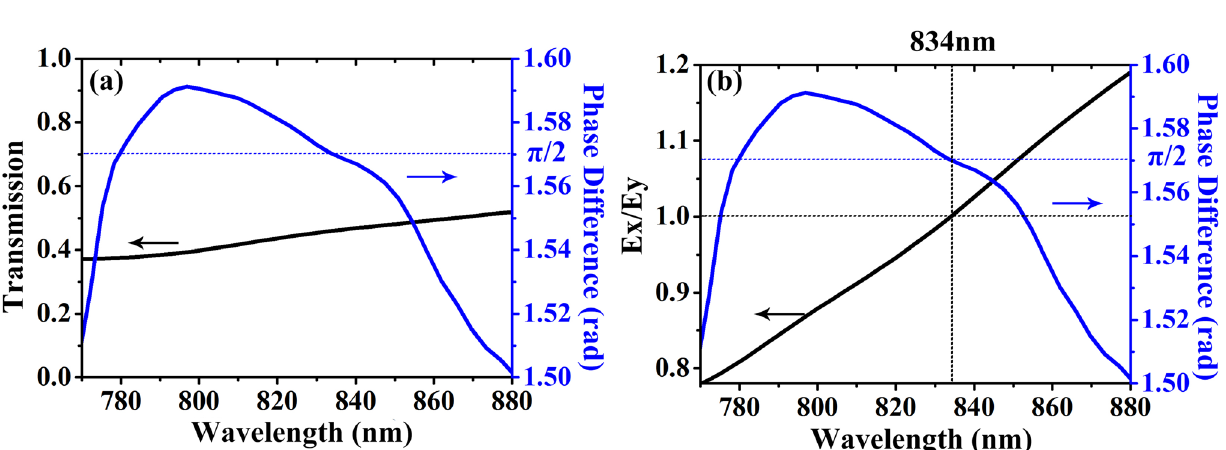
Figure 6. Performance of the proposed NCQW. ( a ) The transmission and phase difference between the transmitted electric fields along X and Y axes of the proposed NCQW. ( b ) The amplitude ratio of the two orthogonal components of electric field along X and Y axes and their phase difference of the proposed